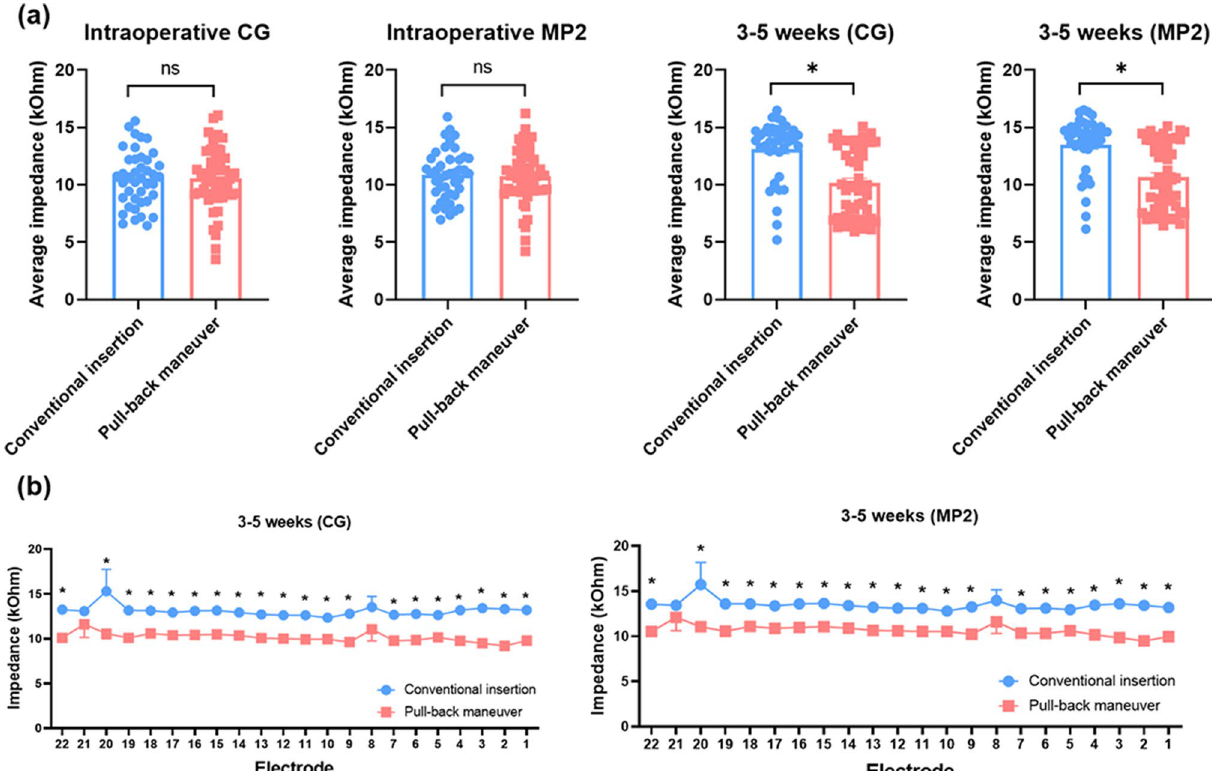
Figure 5. Comparison of intraoperative and postoperative impedance across electrode contacts between the conventional insertion and pull-back maneuver groups for cochlear implant recipients with slim modiolar electrode. ( a ) Average impedance values using monopolar (MP2) and common ground (CG) stimulation configurations intraoperatively and postoperatively. ( b ) Postoperative impedance per electrode contact using MP2 and CG modes. Data are means ± standard error of mean (SEMs). *Statistical